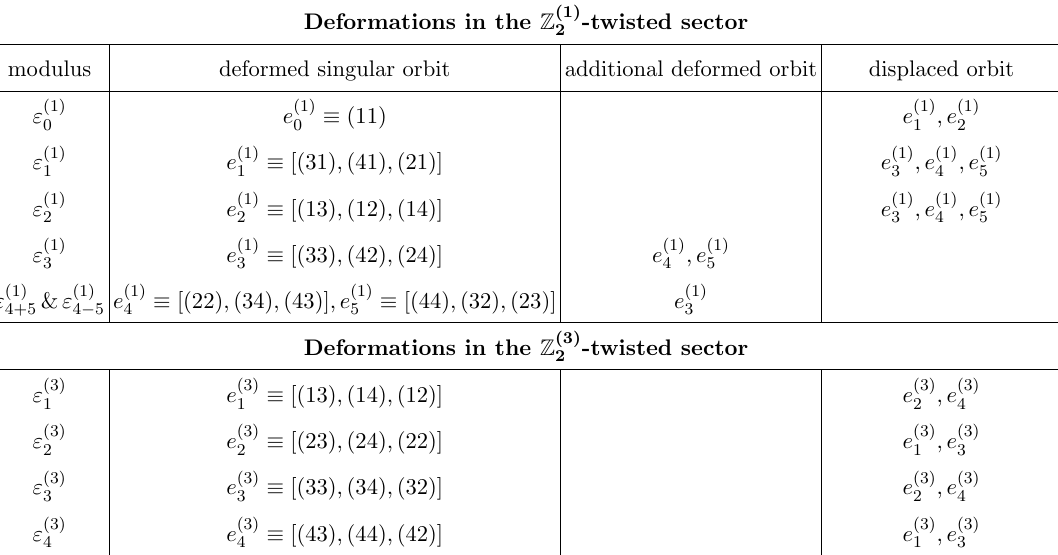
Table 9 . Overview of the deformed singular Z 3 -orbits composed of the Z ( i ) T 6 = ( Z 2 (cid:2) Z 6 (cid:2) (cid:10) R ) with discrete torsion per deformation parameter " (1) third column indicates which other singular orbits are deformed, while the last column lists which or- bits remain singular but are displaced. Figure 3 provides a graphical representation of how the Z (1) singularities (11), (13), (31) and (33) on T 4 points belonging to the respective Z 3 -invariant orbits are not depicted as they do not lie in the R